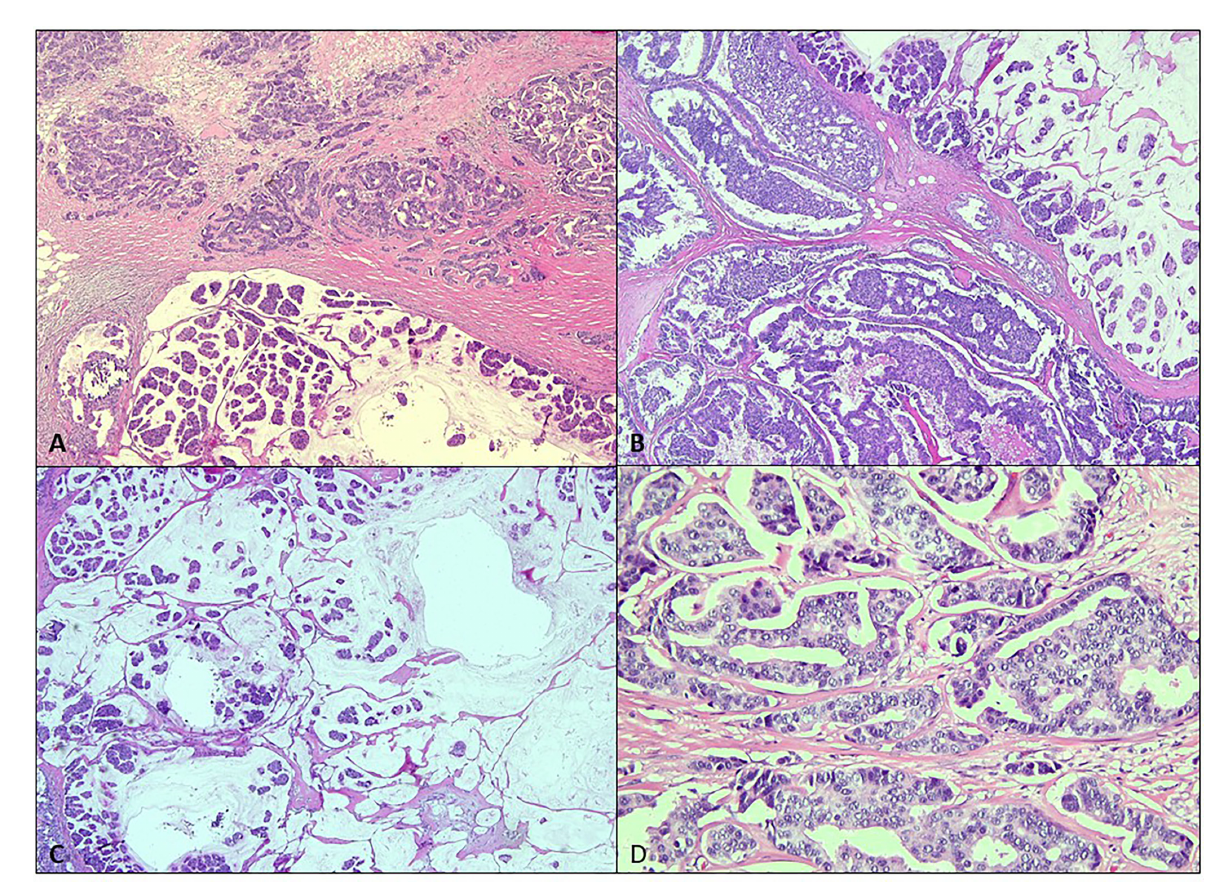
FIGURE 4 Microscopic analysis of the left breast. (A, B) The left breast tumor shows variable morphology of invasive carcinoma comprised of in fi ltrating small ducts, cords, and cribriform glands with a micropapillary pattern (H&E, ×4). (C) Clusters of cells fl oating in mucin pools (H&E, ×4). (D) The malignant cells display pleomorphic vesicular nuclei with inconspicuous nucleoli (H&E,